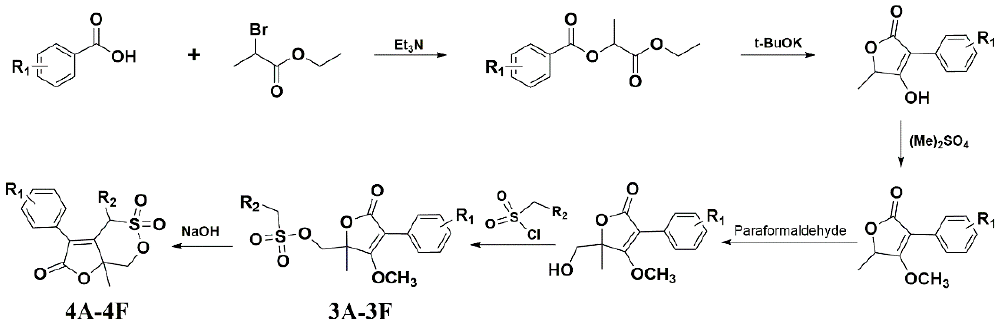
Figure 1. Synthesis route for compounds.